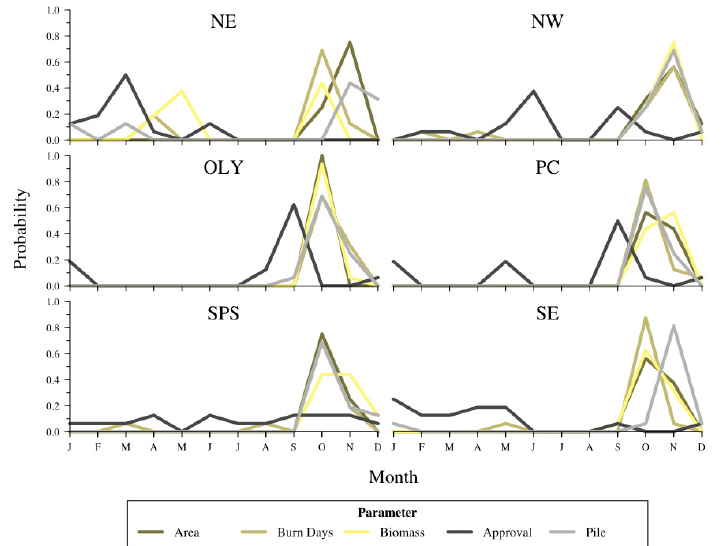
Figure 7. The probability that each month will have the highest prescribed fire use for that year according to five prescribed fire parameters. Each panel corresponds to a DNR administrative region: Northeast (NE), Northwest (NW), Olympic (OLY), Pacific Coast (PC), South Puget Sound (SPS), and Southeast